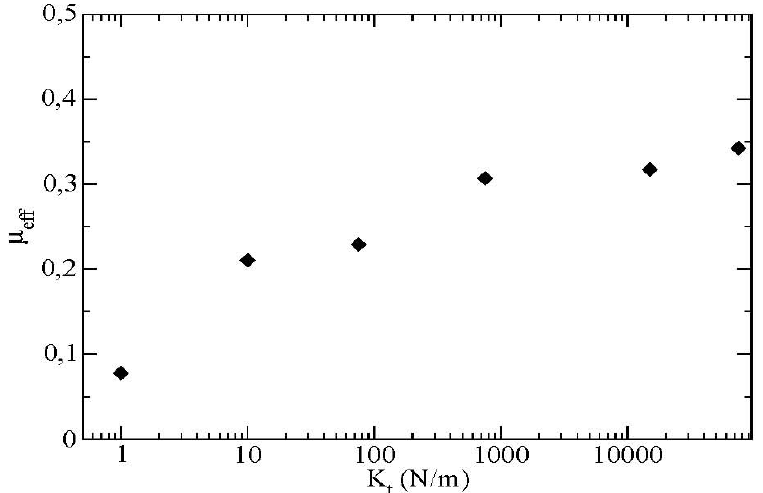
Figure 10. Effective friction at the boundary as a function of the tangential contact stiffness Kt , μ = 0.4, μ ’ = 0.2.